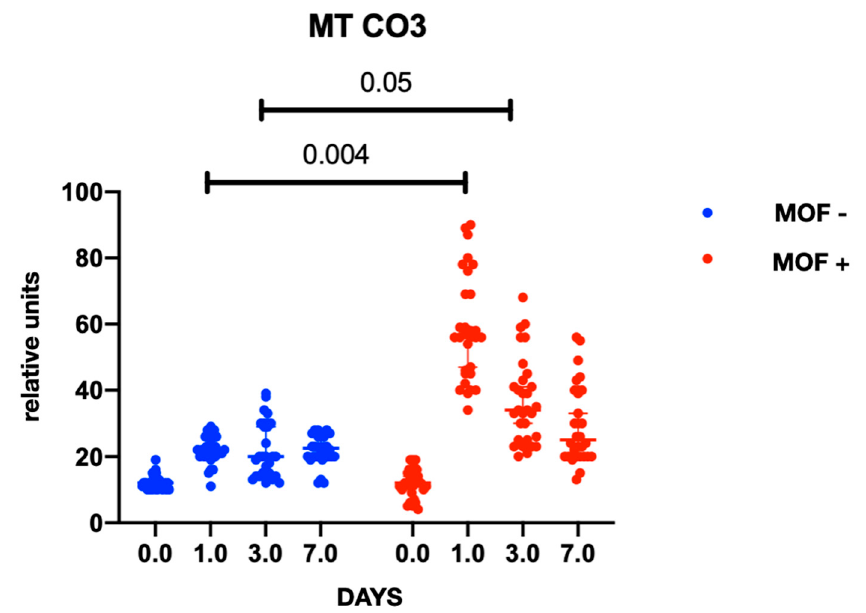
Figure 3. Cytochrome oxidase 3 gene expression.